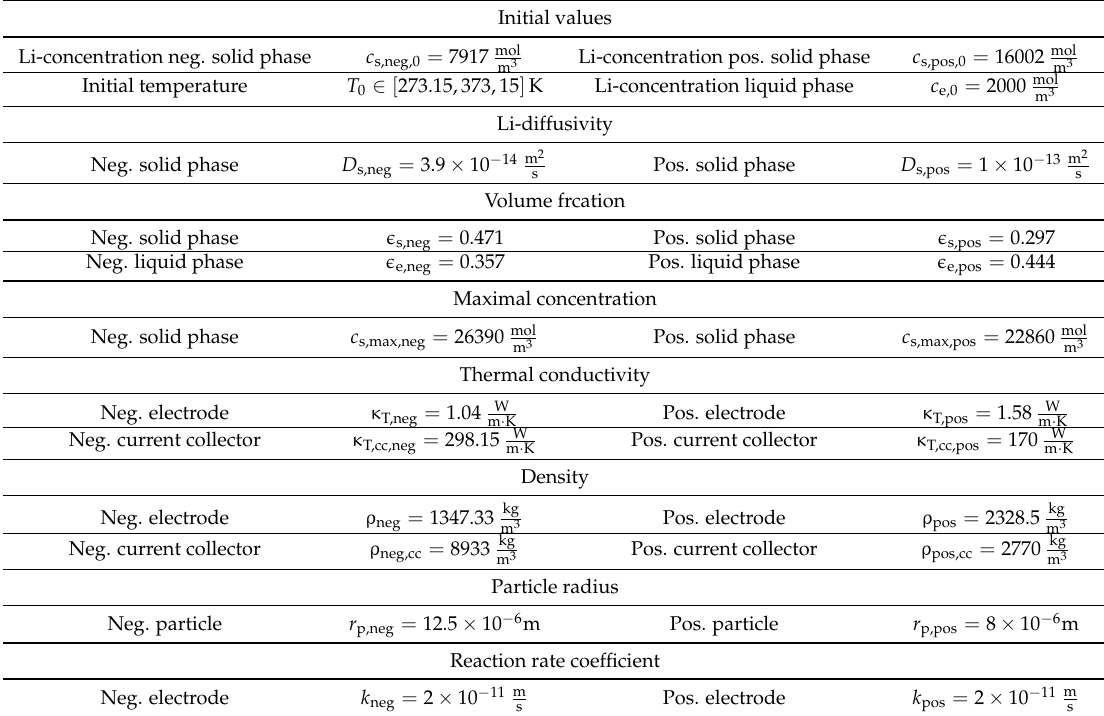
Table A1. Simulation